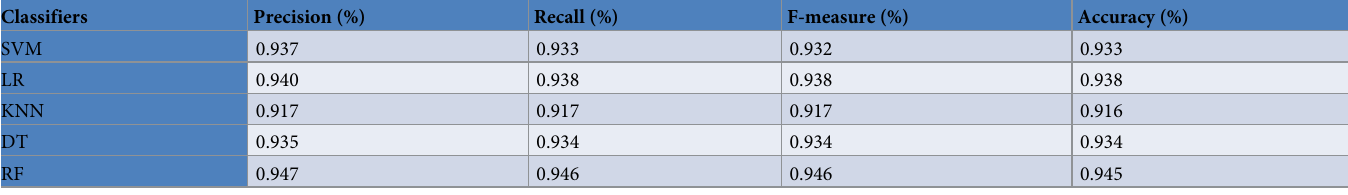
Table 10. Performance results attained on fused features using Pearson